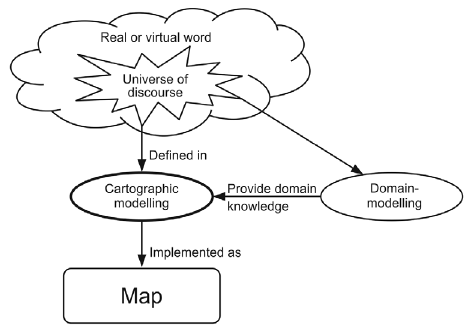
Fig. 1. From real or virtual world to the